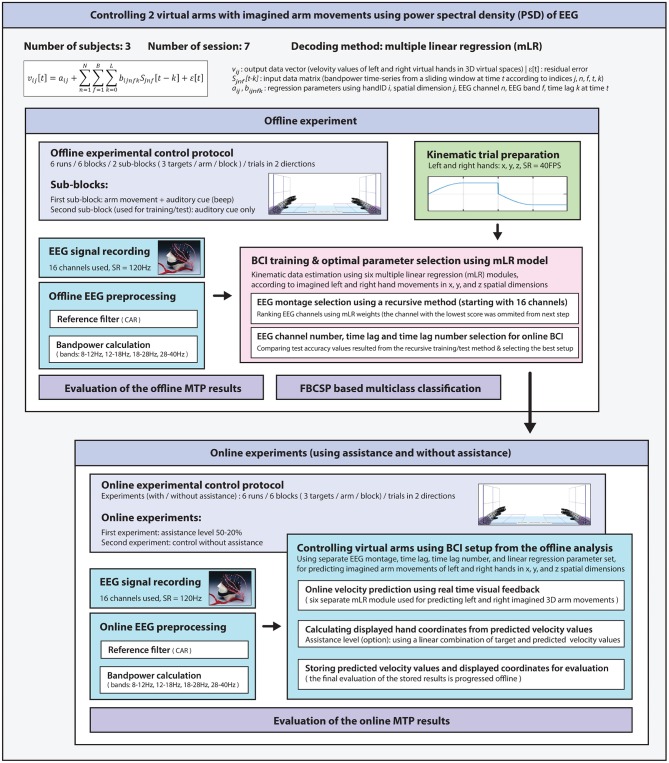
A general overview of the methods used for this study.